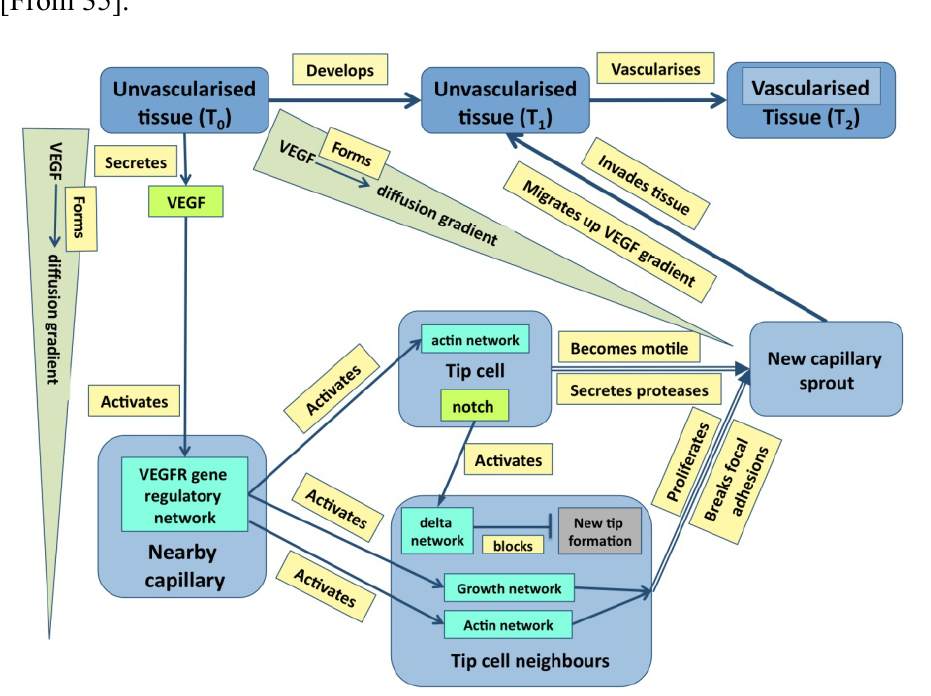
Figure 1. A graph describing some of the core events underpinning angiogenesis. Tissues are in blue, molecular events are in various shades of green, and processes are in pale yellow [From